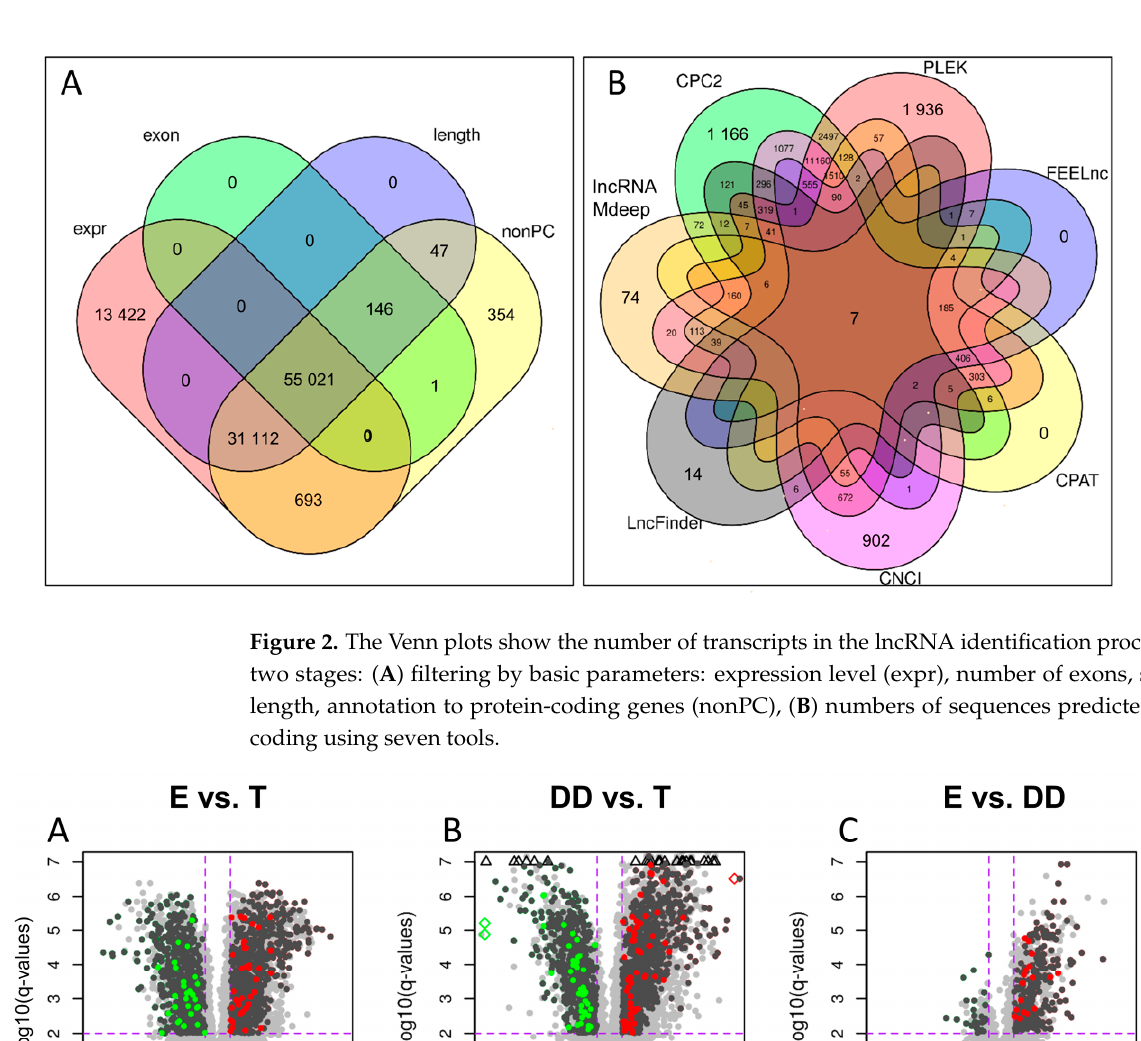
two stages: ( A ) filtering by basic parameters: expression level (expr), number of exons, sequence length, annotation to protein-coding genes (nonPC), ( B ) numbers of sequences predicted as non- coding using seven tools.